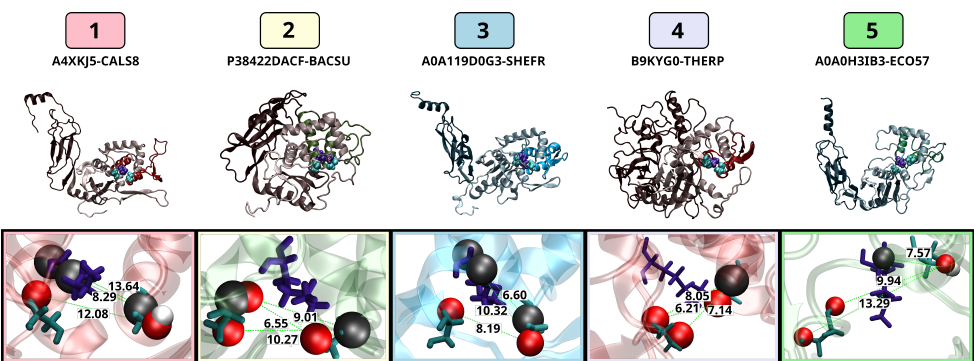
Figure 13. Most central conformations for each conformational state; catalytic SKS residues shown in atom/bond representation, with larger spheres highlighting atoms selected by classification tree (Figure 12) to distinguish conformations. Distances noted are in Angstroms and were calculated in VMD.